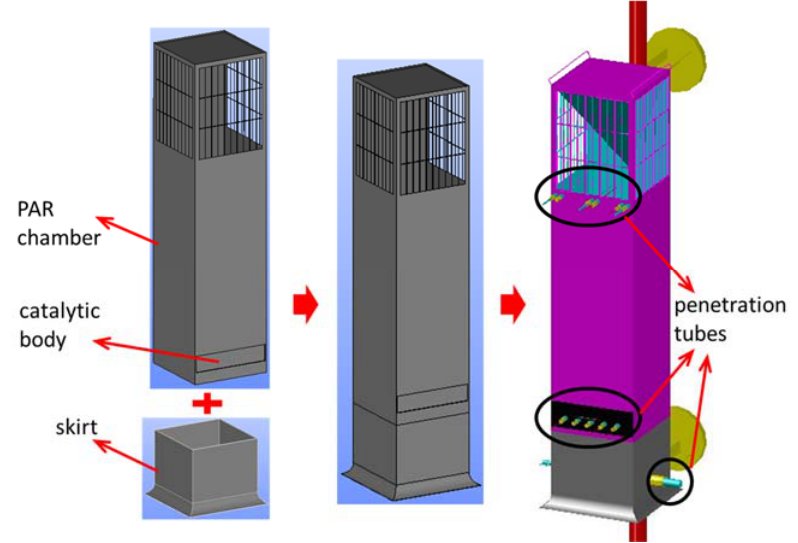
Figure 4. Construction of a test PAR for the SPARC ‐ PAR experiment.